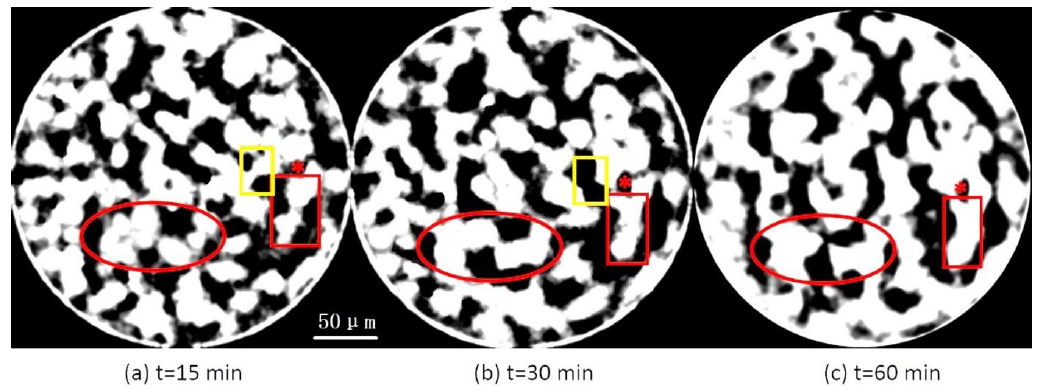
Figure 3. Microstructure of the same cross section at different sintering times of 15 min ( a ), 30 min ( b ) and 60 min ( c ).